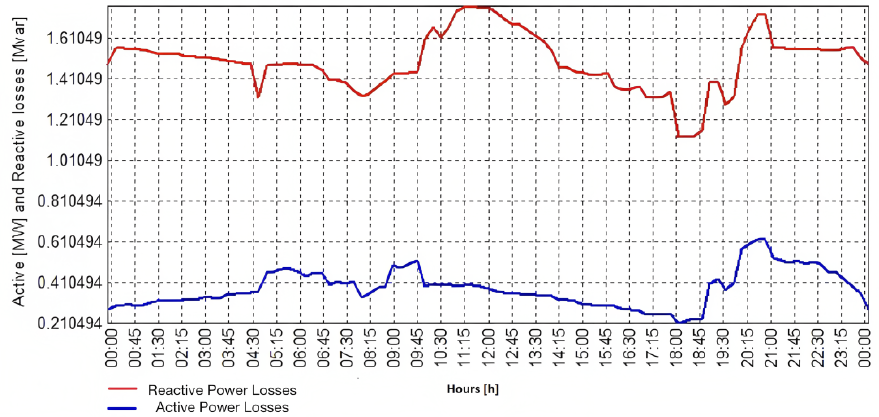
Figure 23. Power line losses.